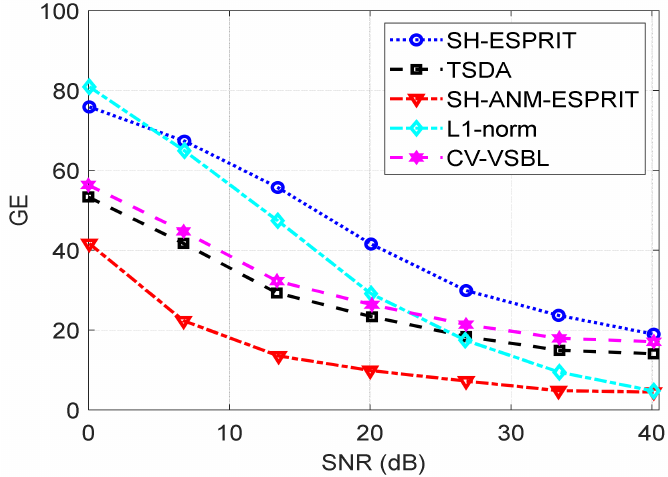
Figure 9. GE versus SNR performance using real measured data for various